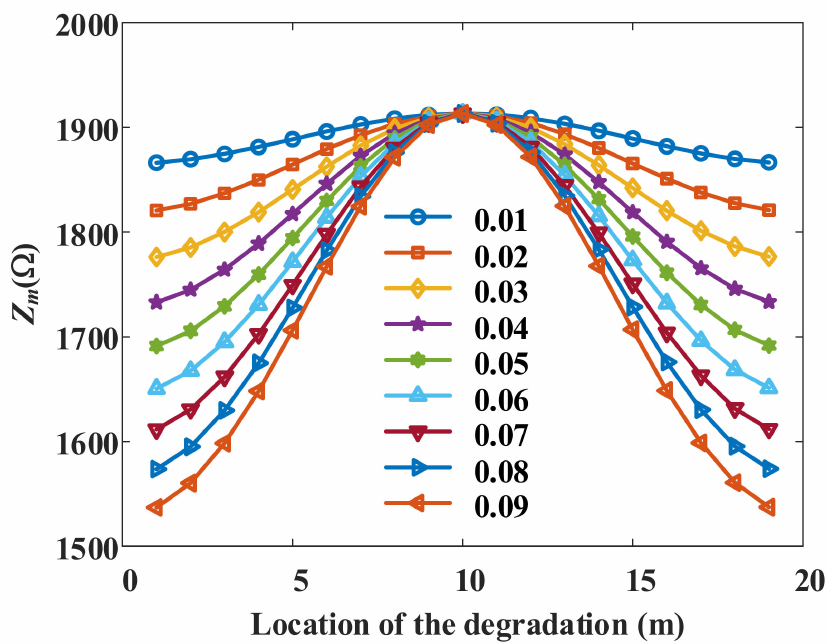
Figure 9. The relationship between the impedance magnitude at the characteristic frequency and the position of the degradation for different physical sizes of local